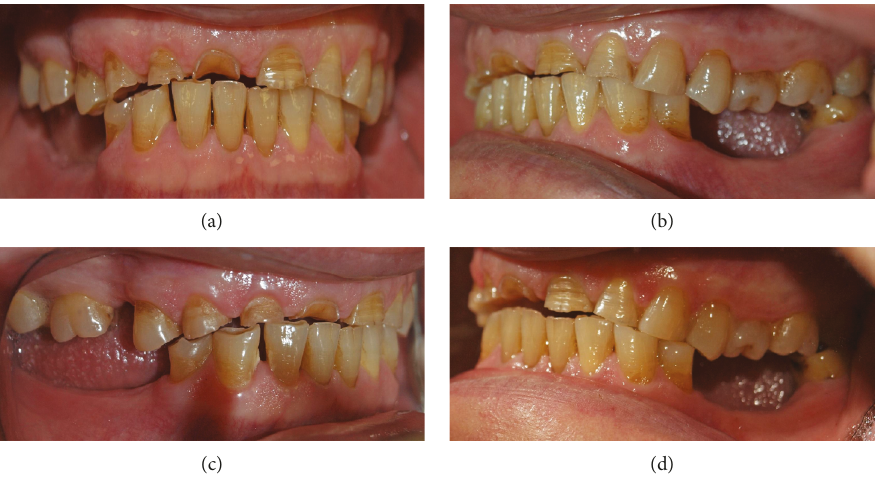
Figure 1: Preoperative images: (a) fontal view; (b, c) lateral views; and (d) opposing tooth facets in eccentric movement.